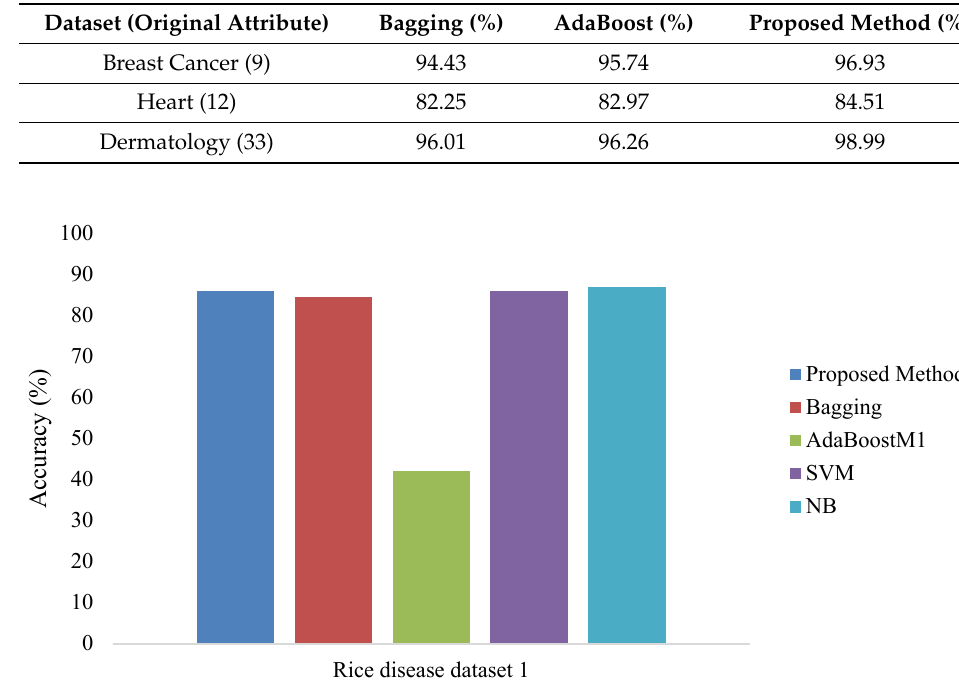
Figure 7. Accuracy for Rice disease dataset2 in the big data environment. Table 1. Comparative Classification accuracy for other disease datasets. Dataset (Original At ‐ tribute) 98.99 Table 2. Comparative Classification values for other disease datasets. Dataset (#Original Attribute)